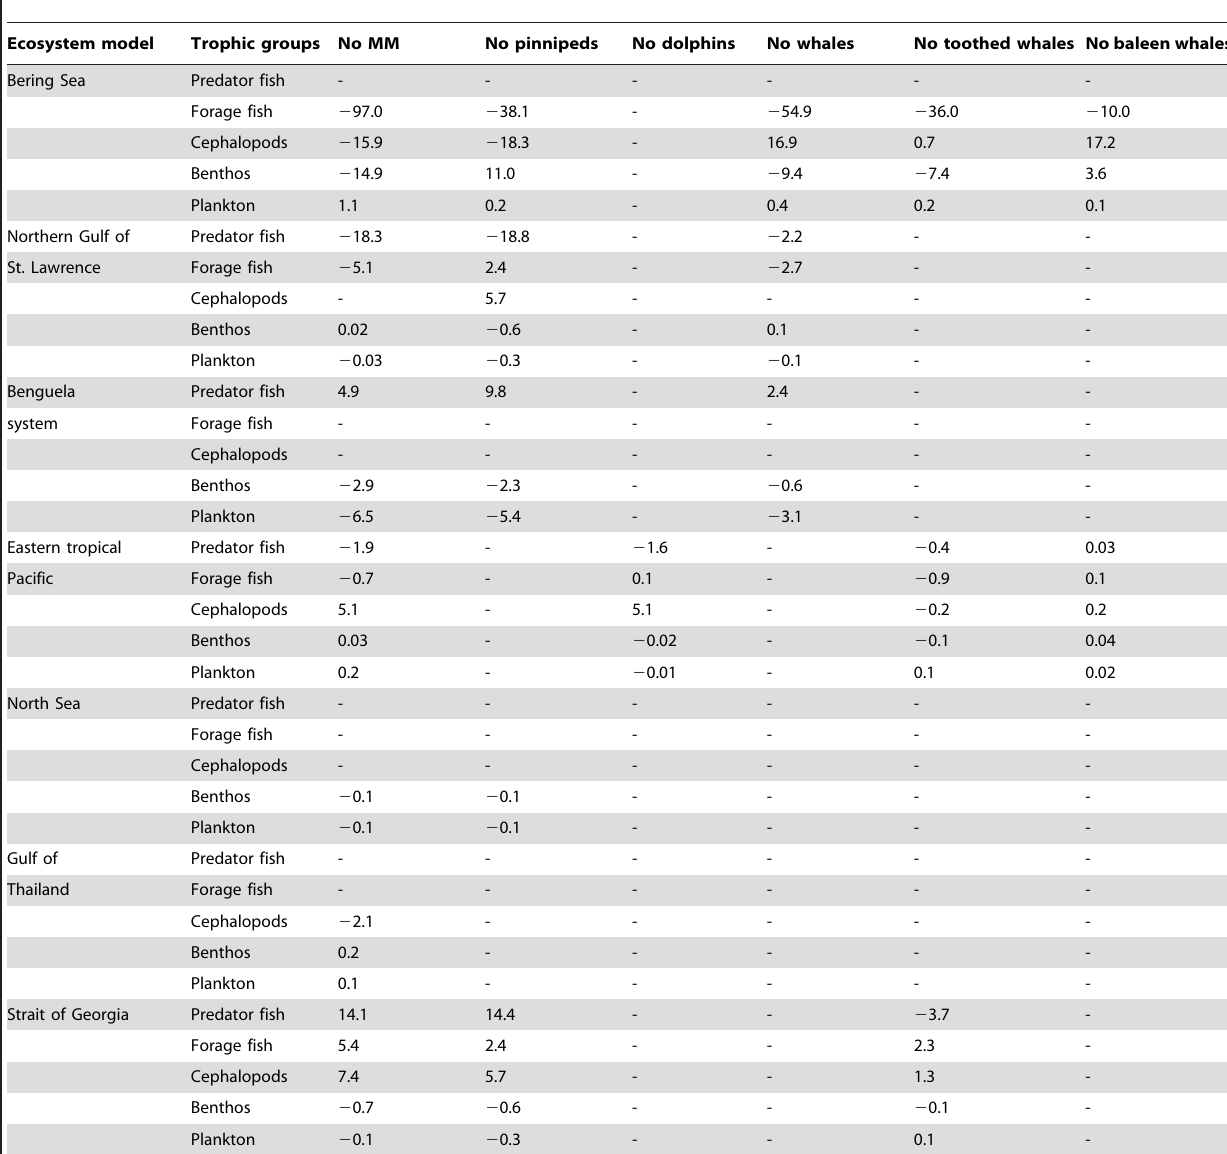
Table 3. Percentages of change in biomass for unfished trophic groups of prey, by different marine mammals groups, in the seven study